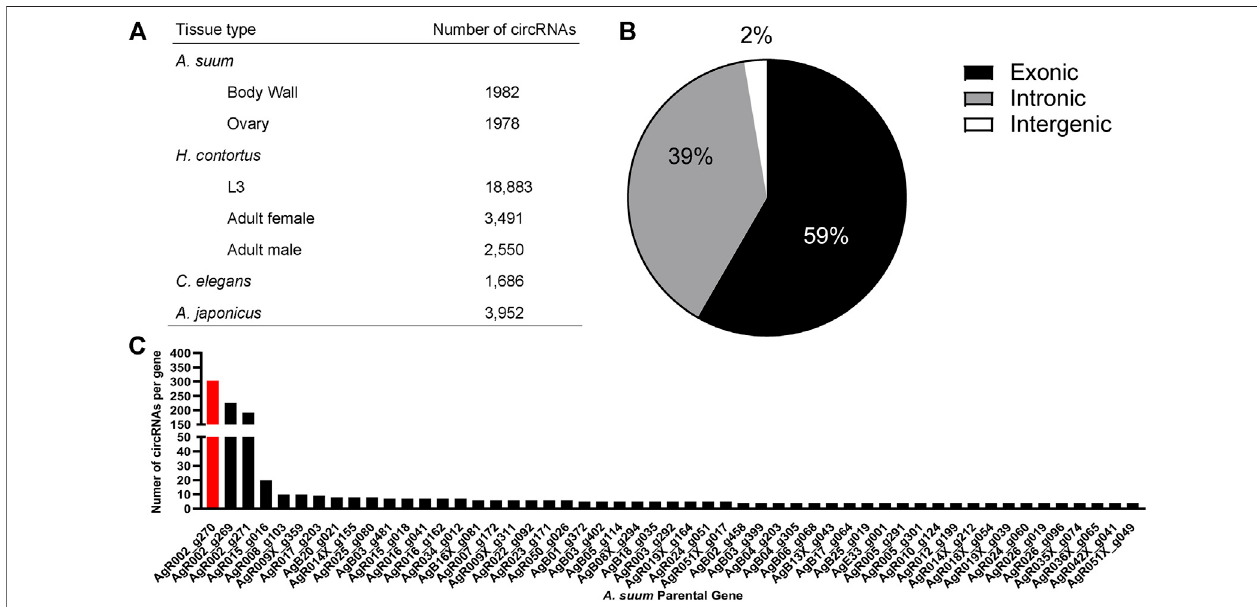
FIGURE 2 | The circRNA complement of Ascaris suum is complex and contains exonic, intronic and intergenic circRNAs. (A) 1,982 circRNAs were identi fi ed in A. suum body wall tissue and 1,978 circRNAs were identi fi ed in ovary-enriched tissue. The total number of distinct A. suum circRNAs identi fi ed in both tissues was 1,997. By comparison, 20,073 circRNAs have been identi fi ed in the small ruminant gastrointestinal nematode Haemonchus contortus (Zhou et al., 2021), with the highest numberfoundintheL3stage(18,883).Inthefree-livingnematode Caenorhabditiselegans ,1,686exoniccircRNAsareknownacrossmultiplelife-stages(Memczak etal.,2013;Ivanovetal.,2015;Cortés-Lópezetal.,2018),while3,952circRNAshavebeenidenti fi edin Apostichopusjaponicus adults(Zhaoetal.,2019). (B) Themost abundant form of circRNAs found in A. suum were exonic circRNAs, followed by intronic circRNAs with the least abundant being intergenic circRNAs. This is consistent withcircRNApro fi lesinotherspecies. (C) AfrequencydistributionshowingthenumberofcircRNAsderivedfromspeci fi c A.suum genes.Onlythosegenesgeneratedat least four circRNAs are shown. Three A. suum genes are particularly enriched, with AgR002_g270 (red) had the highest amount of circRNAs (generating the greatest number of circRNAs,